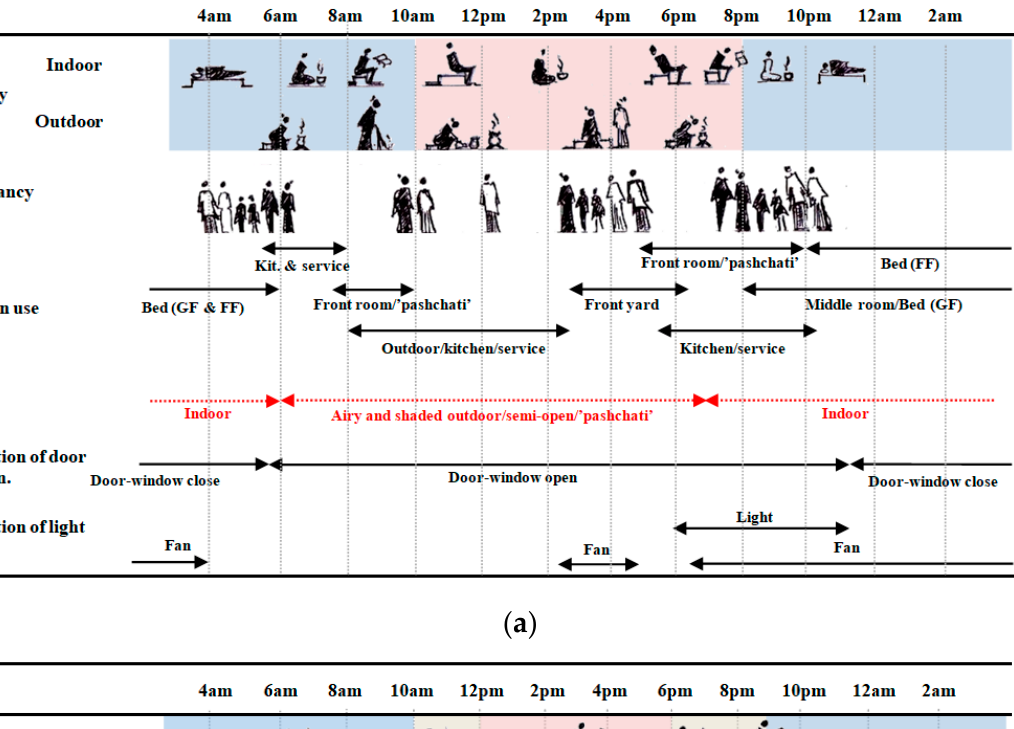
( b ) Figure 12. Installation of light and fan: ( a ) single/double-storied, ( b ) stilt timber house. Therefore, it can be concluded that people use indoor spaces mostly during night when the indoors become comfortable and operation of fan is preferred for enhanced